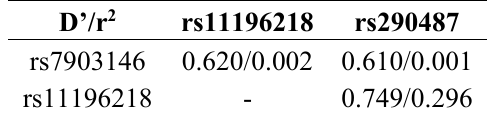
Table 14. The linkage disequilibrium (as D’/r2) between SNPs of TCF7L2 gene in the Chinese